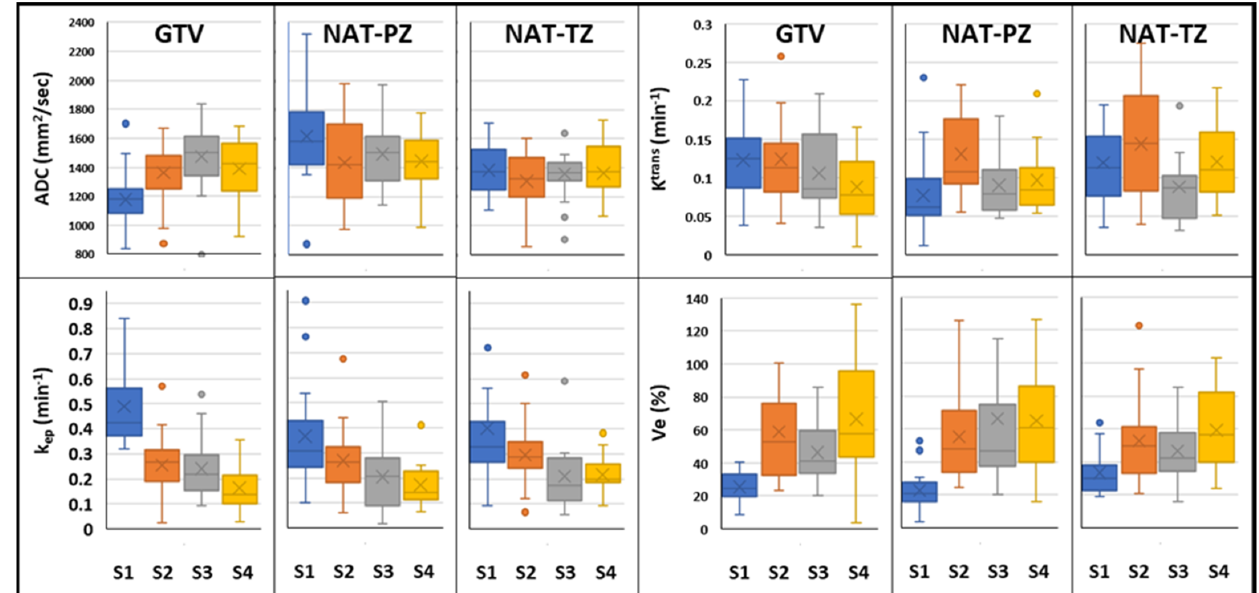
Figure 5. Longitudinal changes of quantitative imaging characteristics before and after LEAD-RT: Box and whisker plots comparing ADC, K trans , k ep , and v e in GTV, NAT-PZ, and NAT-TZ from longitudinal mpMRI exams acquired at pre-RT (S1) and at 3 scans at 3- (S2), 9- (S3), and 24-months post-RT (S4).